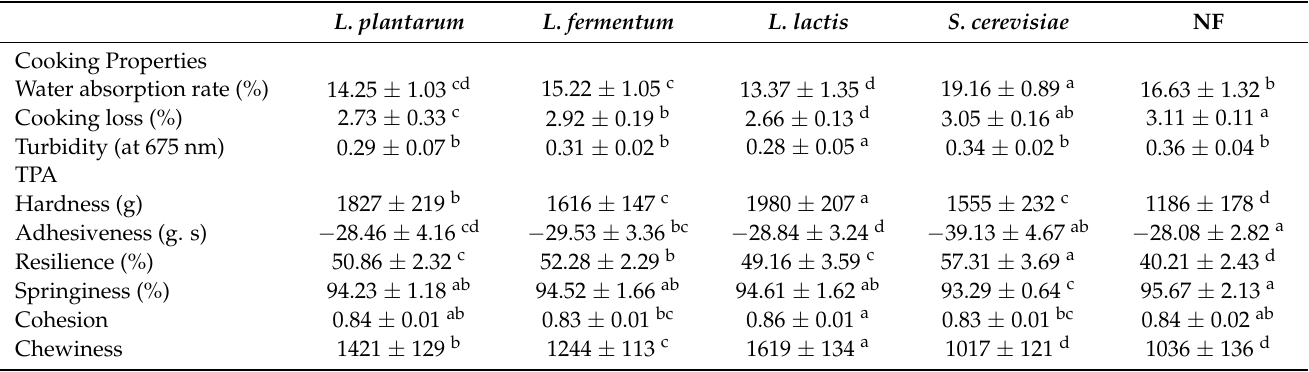
Table 1. Cooking properties and texture profile analysis (TPA) of five fresh fermented rice